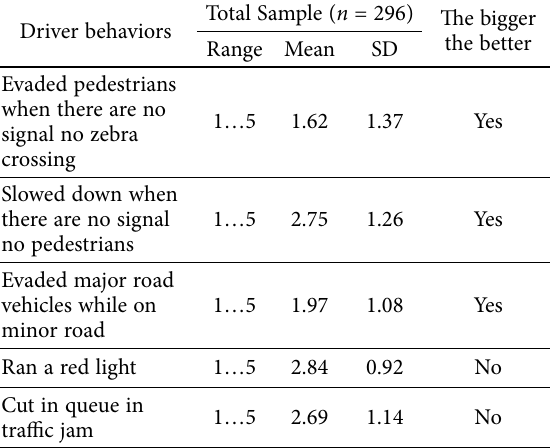
Cut in queue in traffic jam